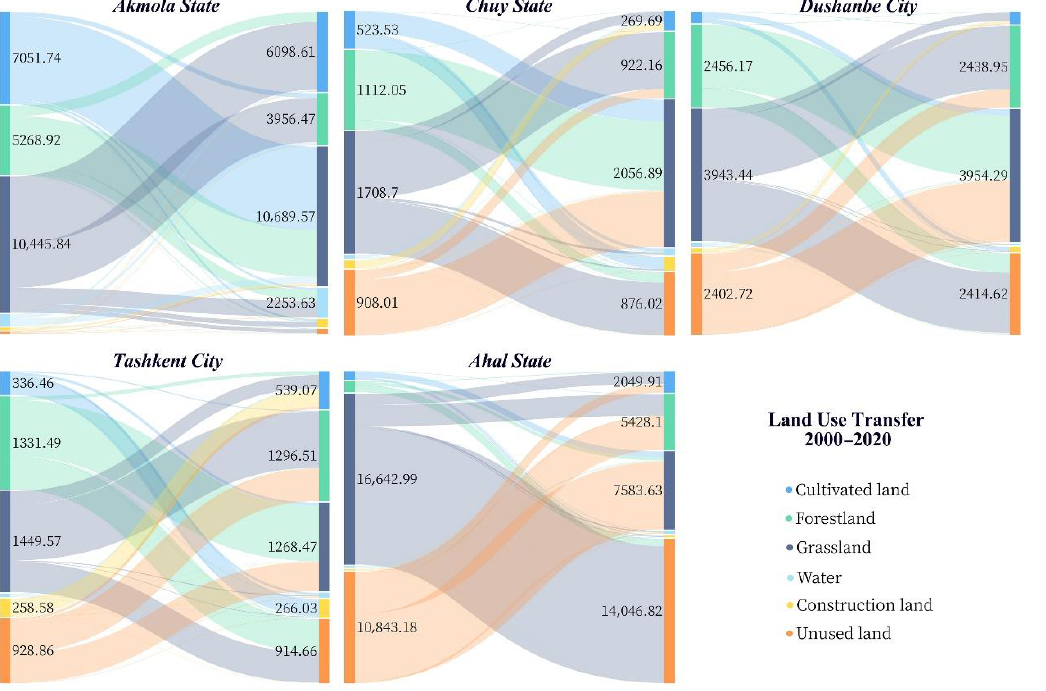
Figure 6. The main transfer relationship between land use types. From 2000 to 2020, the area of grassland transferred out in Akmola State was the largest, and the area converted into cultivated land accounted for 49.49% of the total area